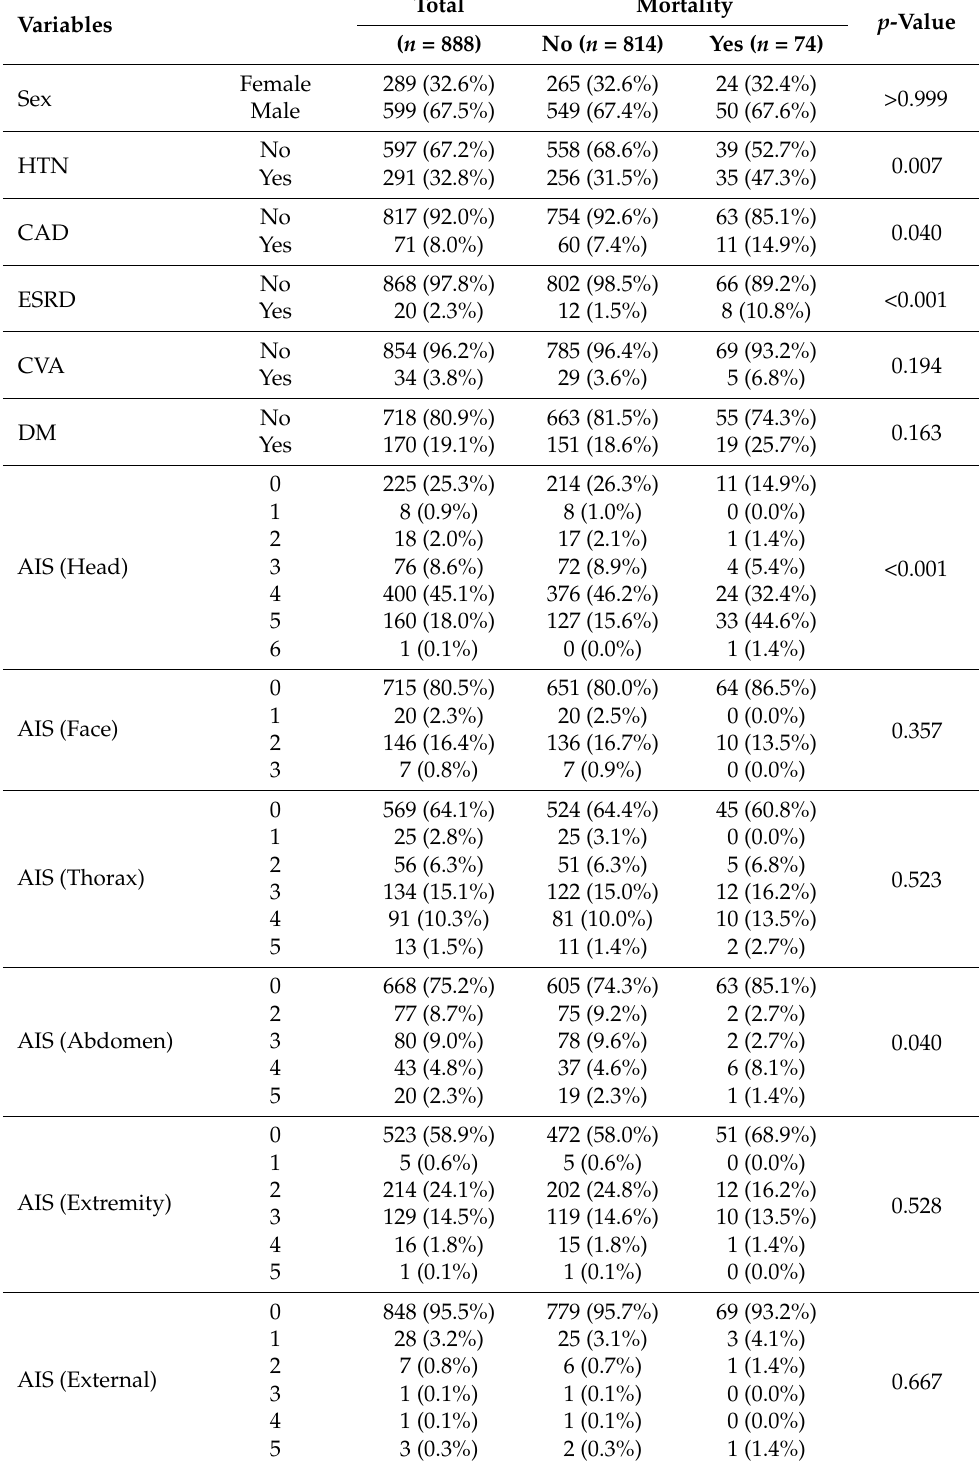
Table 1. Categorical variables of patient and injury characteristics of the death and survival adult trauma patients who were admitted into the intensive care